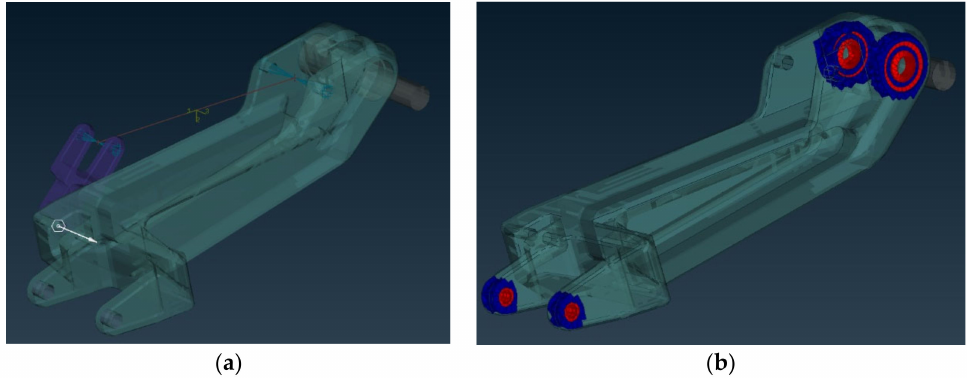
Figure 7. Connections modeled: ( a ) with bolts; ( b ) with